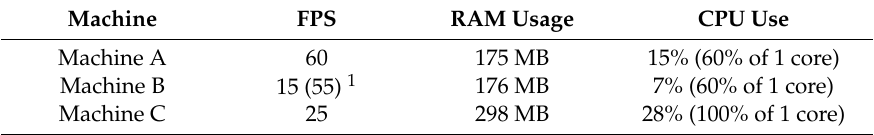
Table 2. The measured performance characteristics of the Web-GIS client running on different